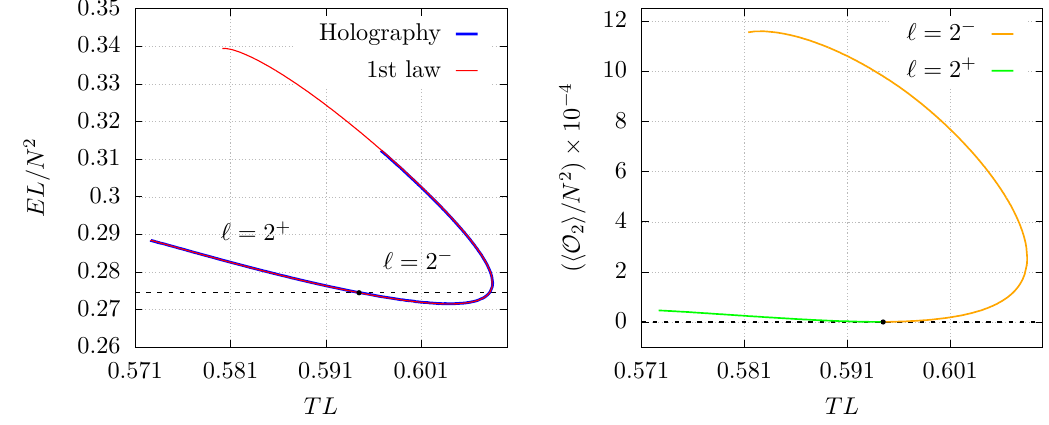
Figure 9. Left: energy comparison for the ‘ = 2 lumpy black hole family when computed by integrating the 1st law of thermodynamics (red line) and when computed using holography (4.4) (blue line). Right: dimensionless vev of the dual lower-dimensional scalar operator S 2 as a function of the dimensionless